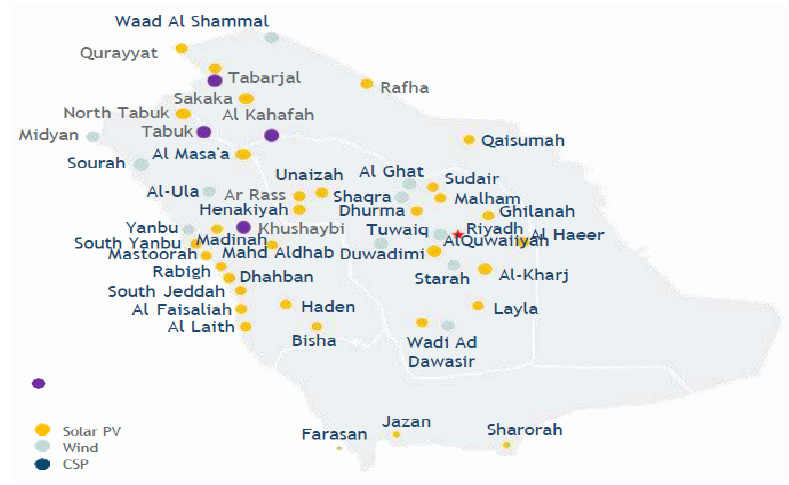
Figure 1. Location of renewable energy projects to be deployed across Saudi Arabia.